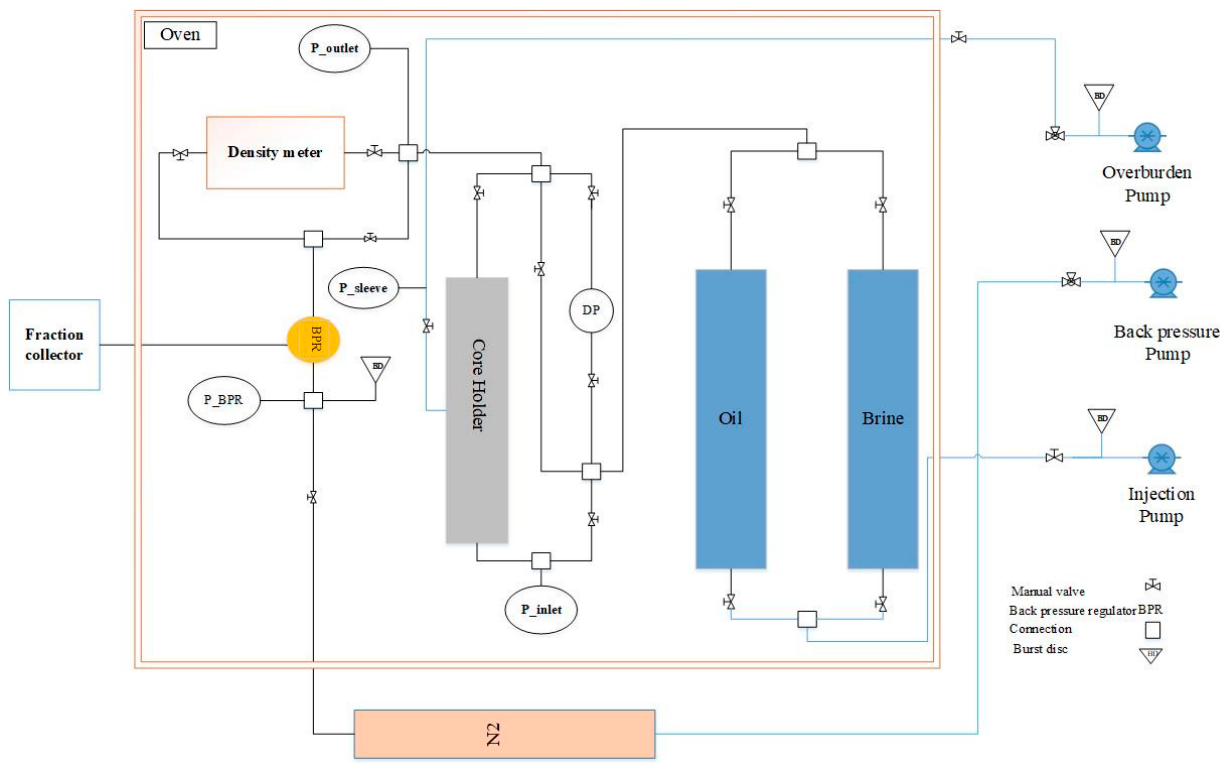
Figure 3. Schematic of core flooding apparatus used in the study. The equipment mounted in the oven (the orange line) to be kept at reservoir temperature.